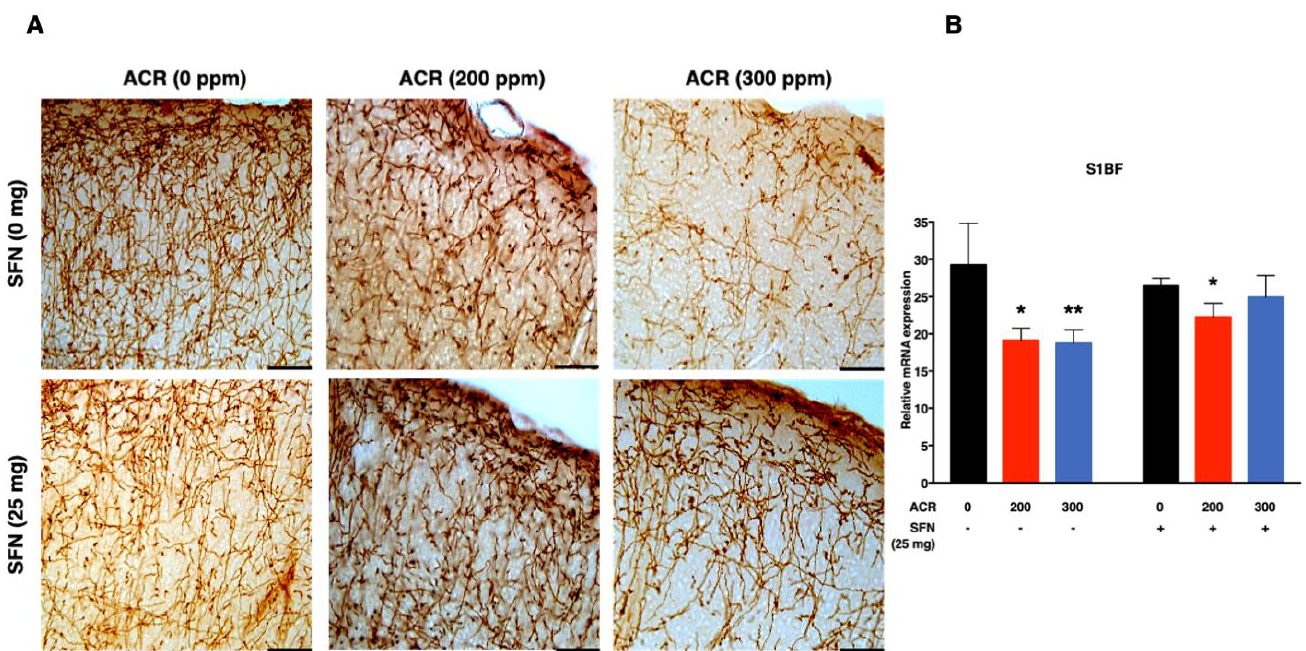
Figure 2. Representative photomicrographs ( A ) and density ( B ) of noradrenaline transporter (NAT)-immunoreactive axons